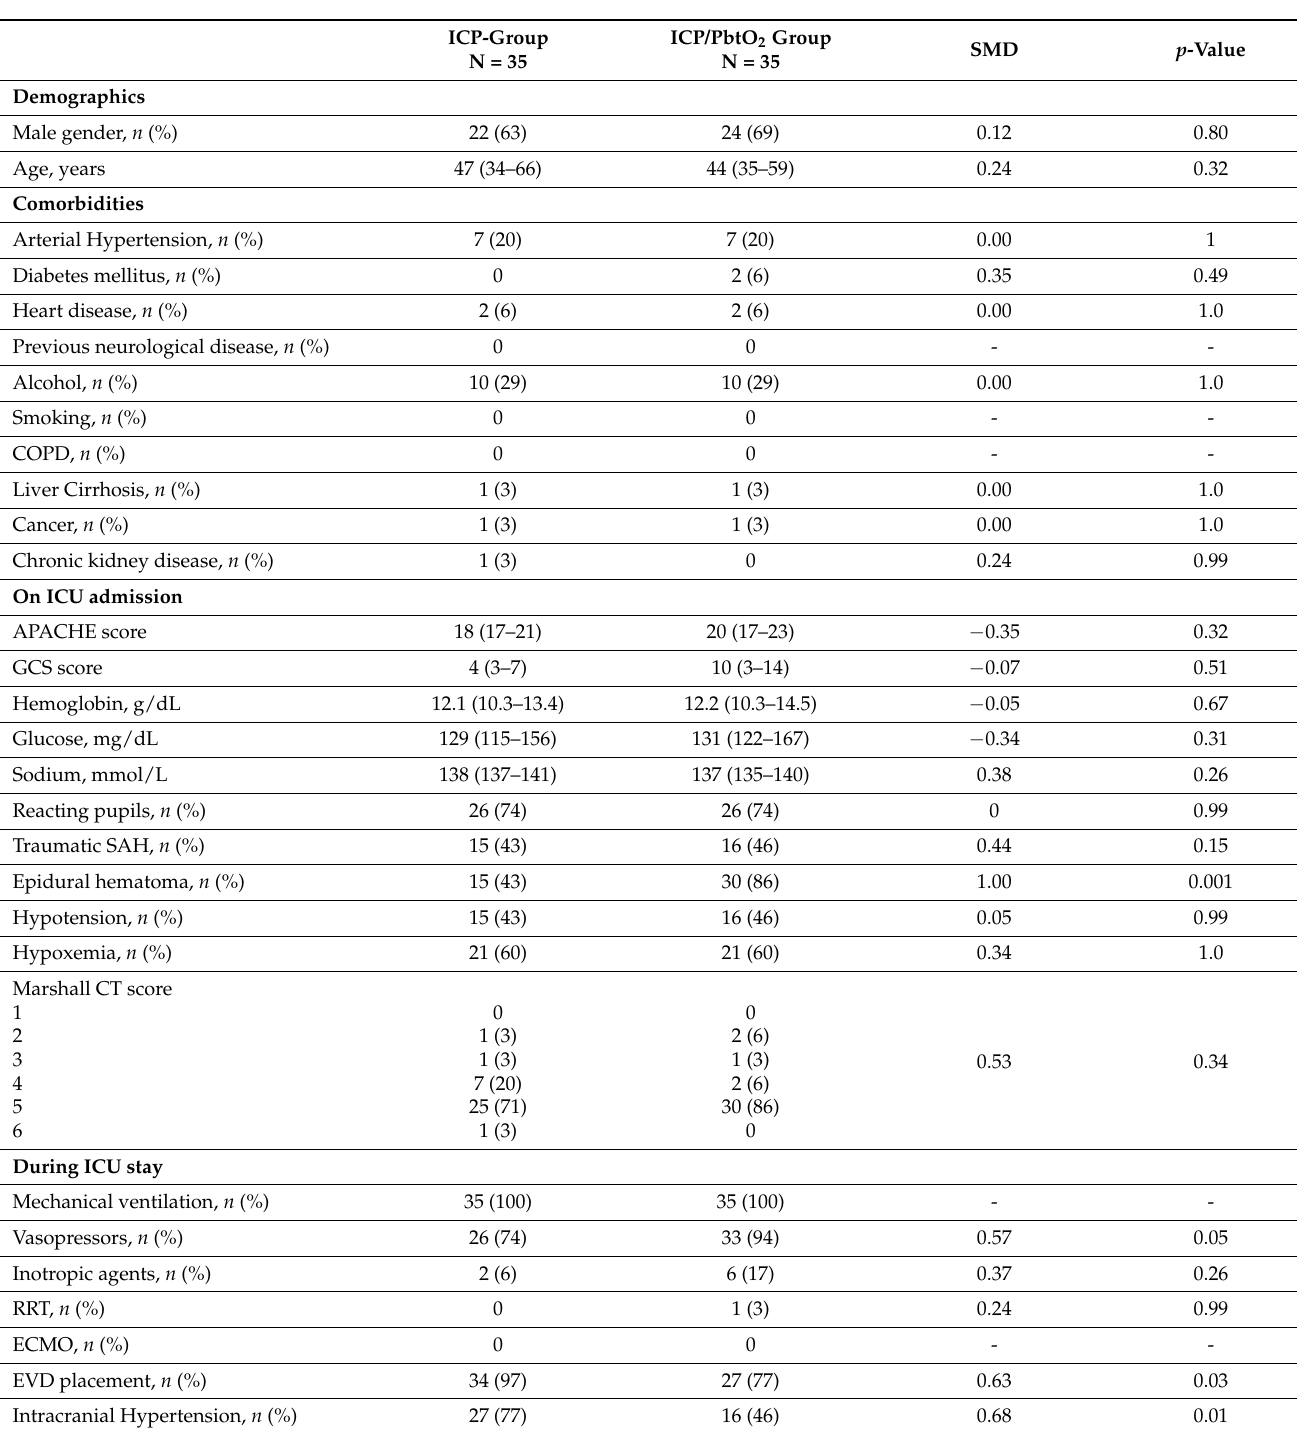
Table 2. Comparison of the study matched cohort, according to the use of intracranial pressure (ICP) or ICP and brain oxygen pressure (PbtO 2 ) monitoring. Data are presented as count (%) or median (25th–75th